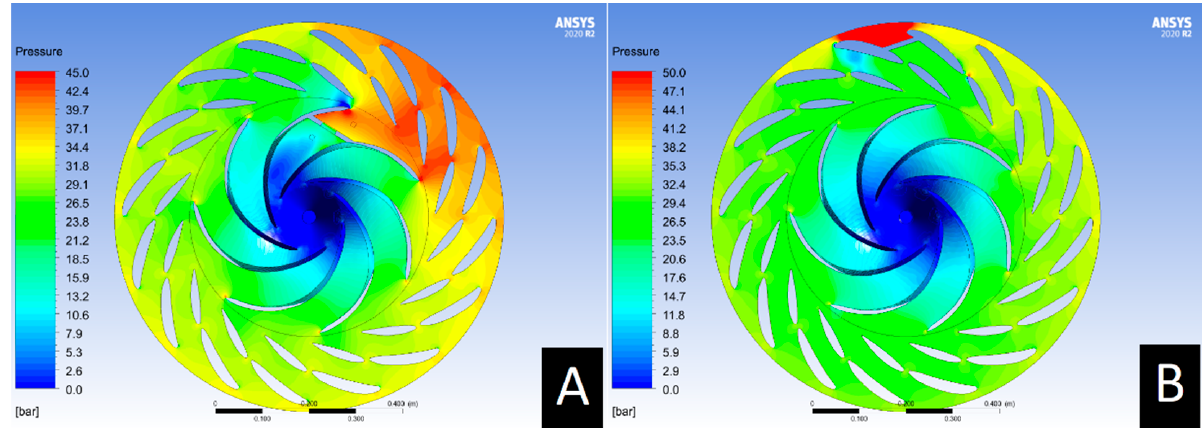
Figure 9. Example of pressure contours obtained for studied cases: ( A ) obstructed rotor; ( B ) obstructed distributor.